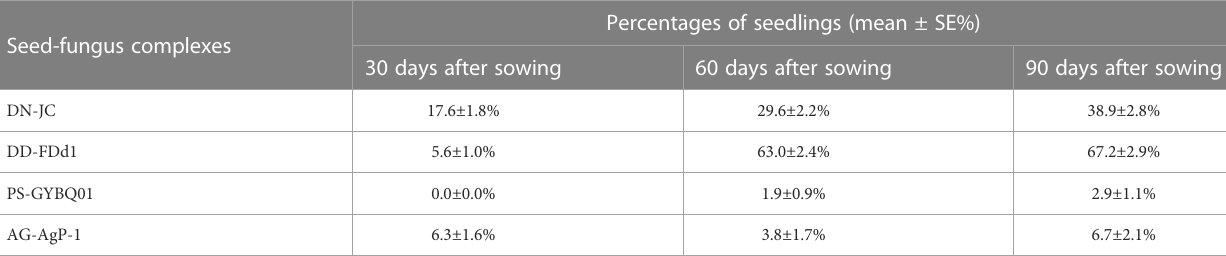
TABLE 2 Seedling formation at 30, 60 and 90 days after sowing of seed-fungus complexes in four orchid species.